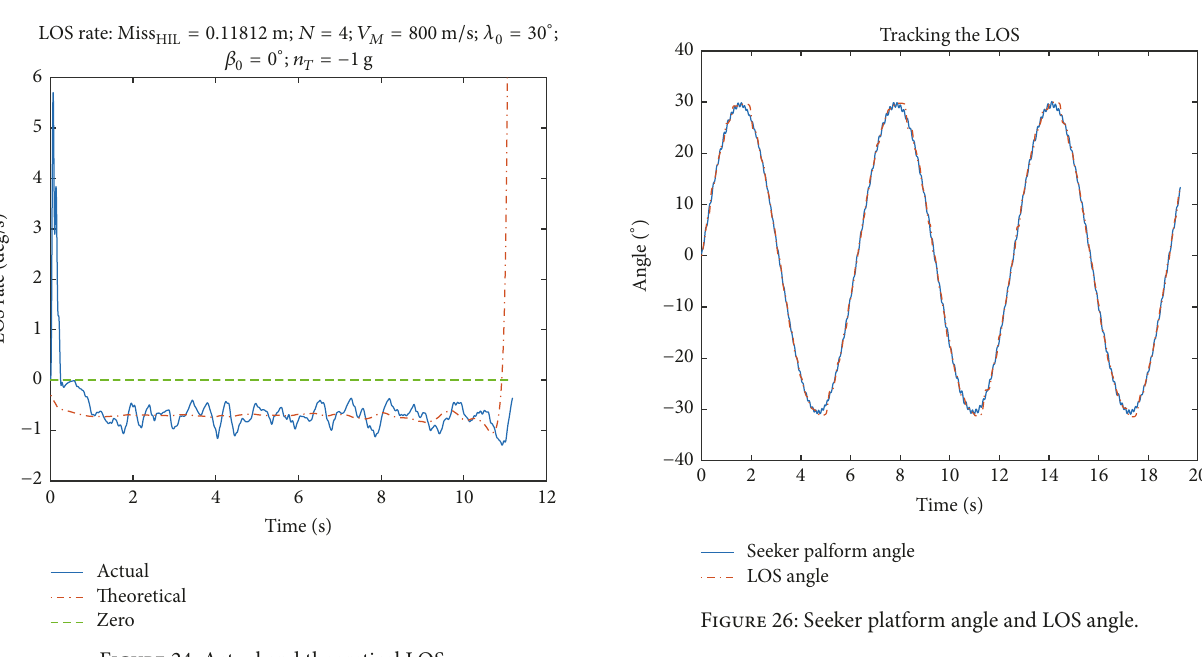
Figure 24: Actual and theoretical LOS.